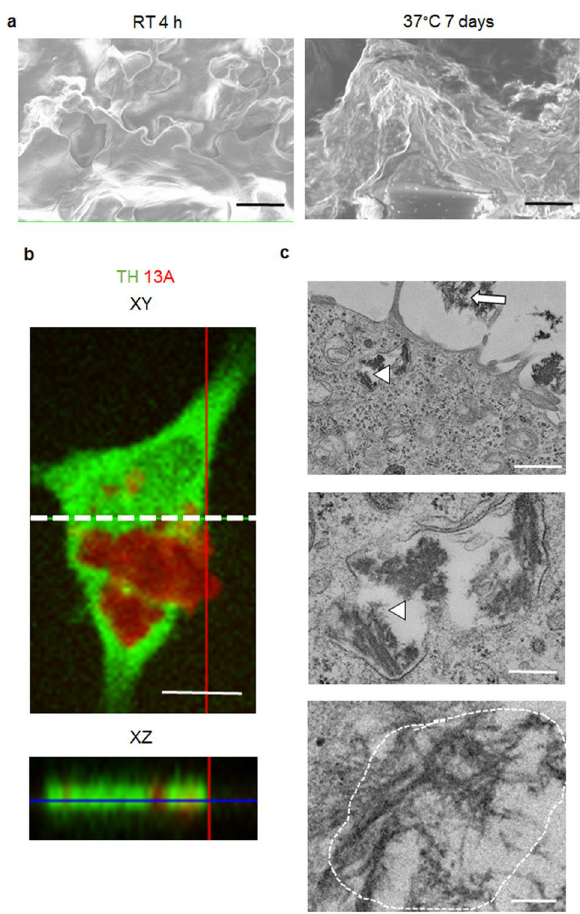
Figure 3. Aggregated 13A is taken up by PC12 cells. ( a ) Scanning electron microscopy images of a TAMRA- labeled 13A peptide (1 mg/mL) incubated for 4 h at RT or 37 °C for 7 d. Each representative image was chosen from 5 images. Scale bars, 5 µm. ( b ) An ortho XZ-axis cross section confocal image of a PC12 cell (bottom) along the dotted line in the XY-axis view (top) was reconstituted from z-stacks using confocal laser scanning microscopy. The interval of z-stacks was set at 1 µm. The cell stained with TH antibody (green) has 13A signals (red). Scale bar, 10 µm. ( c ) Transmission electron microscopy images of PC12 cells with an uptake of aggregated 13A. TAMRA-labeled 13A peptides (1 mg/mL) incubated at 37 °C for 7 d were added to PC12 cells to a concentration of 10 µg/mL in the culture medium. The cells were then cultured for one day and subjected to transmission electron microscopy. The arrow and arrowheads indicate 13A aggregates outside and inside the cell, respectively (top, middle). The 13A aggregates inside the cell are magnified (middle). The fibril-like structure is surrounded by dotted line (bottom). The representative images were chosen from 58 images. Scale bars, 5 μm (top), 1 µm (middle,